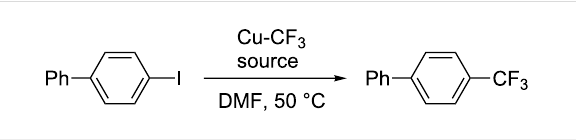
Scheme 3: General protocol for reactions described in Figure